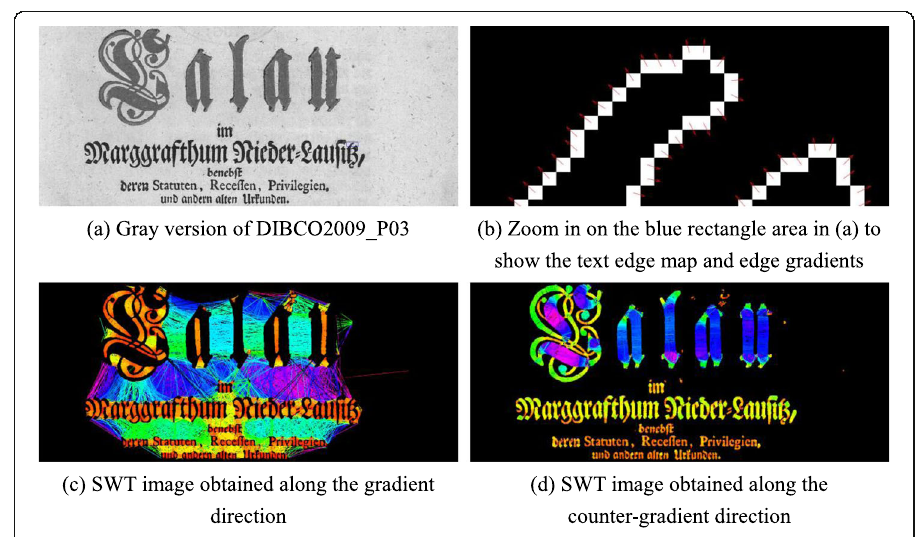
Fig. 4 Implementation of stroke width transform (SWT) and SWT direction determination based on minimum